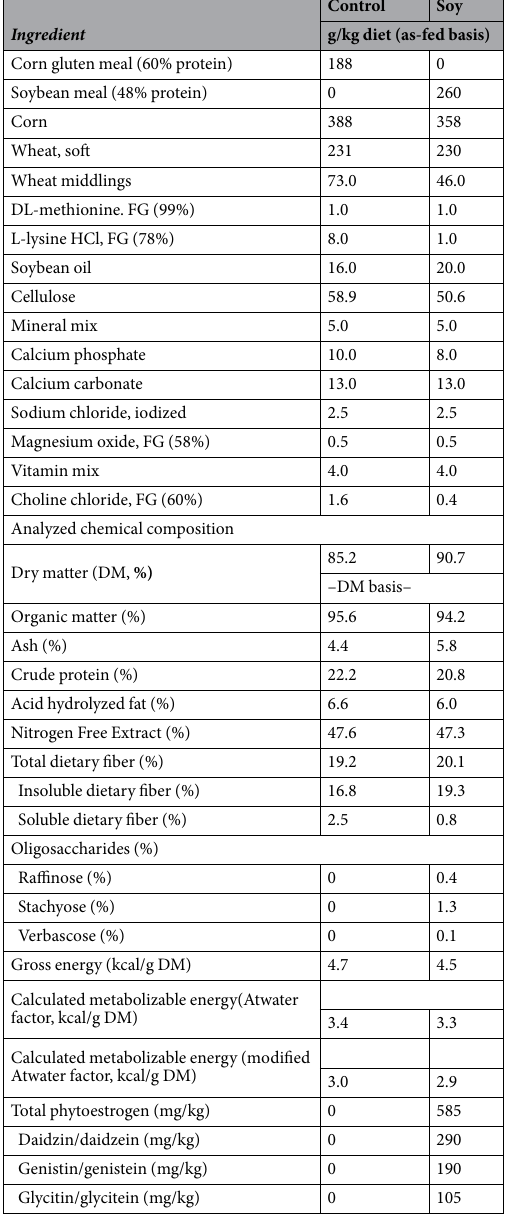
Table 1. Ingredient and analyzed chemical composition of the